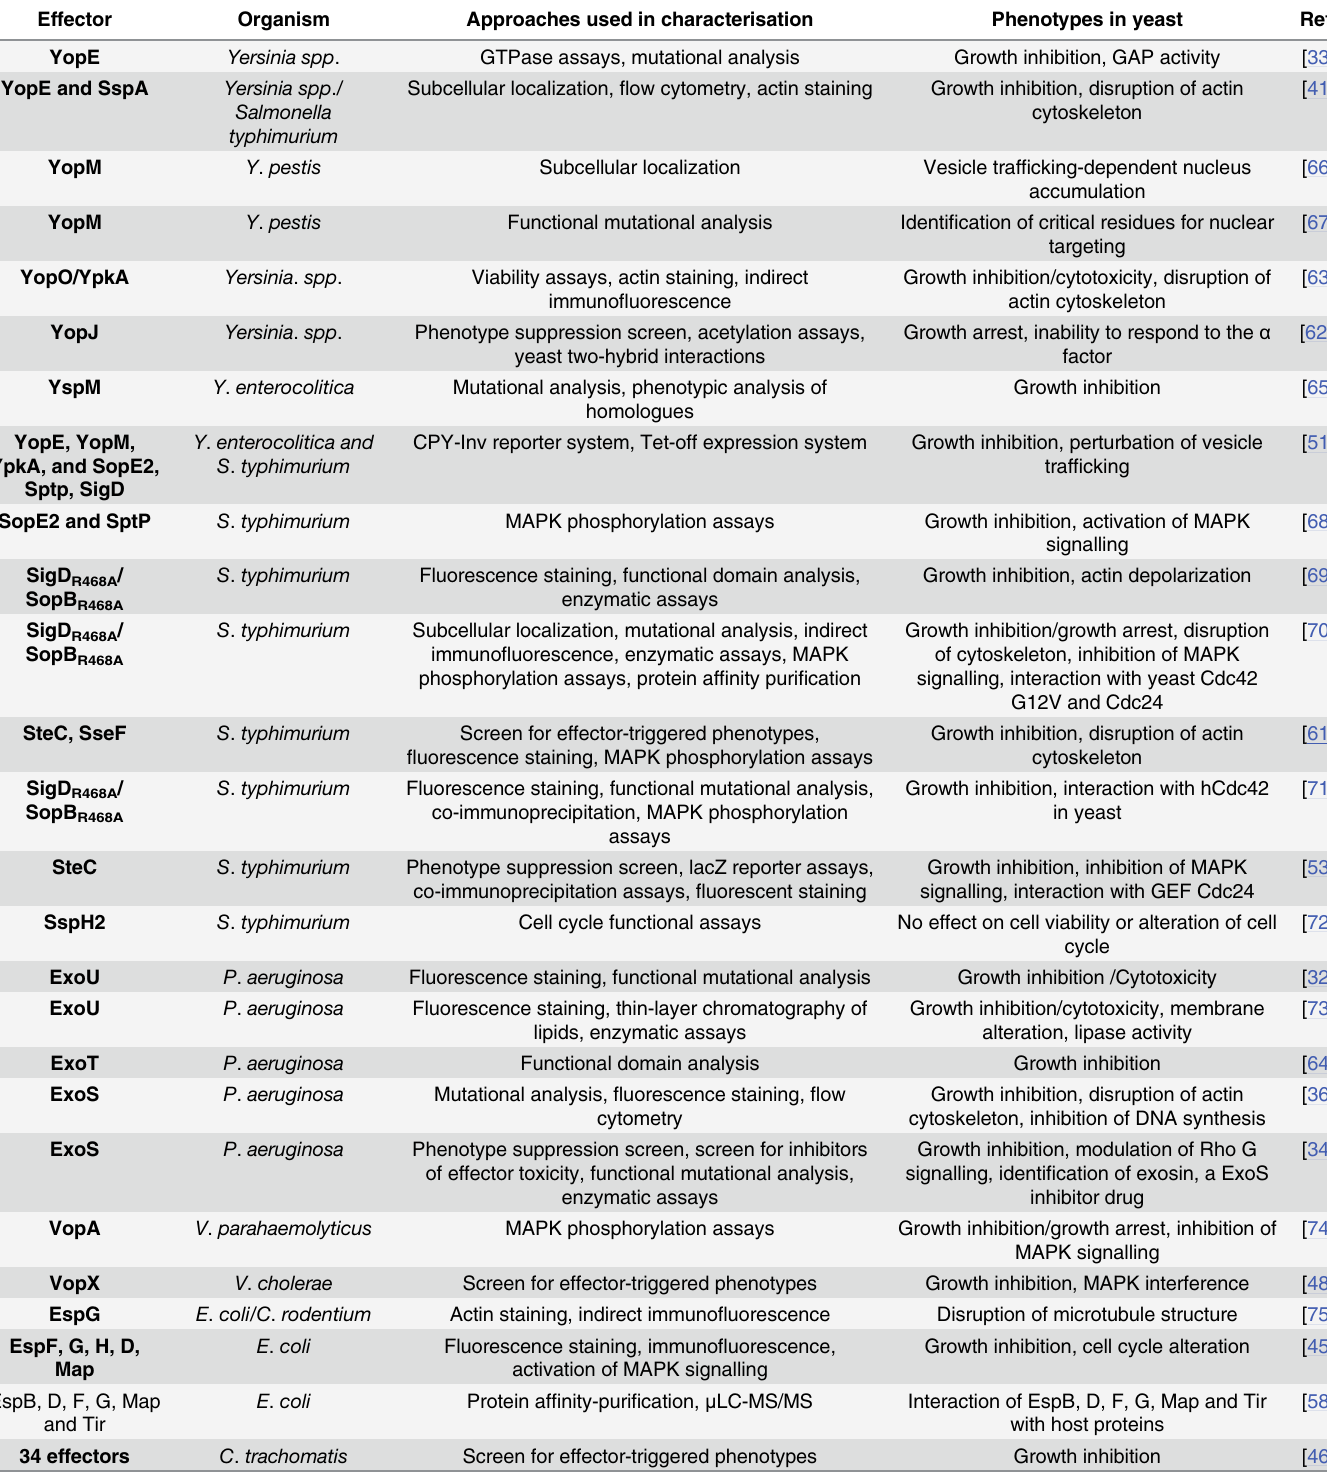
Table 1. List of bacterial T3Es studied in budding yeast. Ref. stands for references. Genera are abbreviated as follows: S . = Salmonella or Shigella , X . = Xanthomonas , E . = Erwinia or Escherichia , P . = Pseudomonas or Pantoea , V . = Vibrio , C . = Chlamydia or Citrobacter